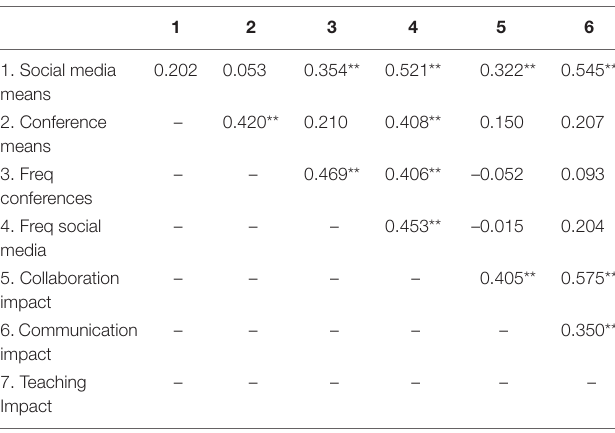
TABLE 4 | Correlations with independent